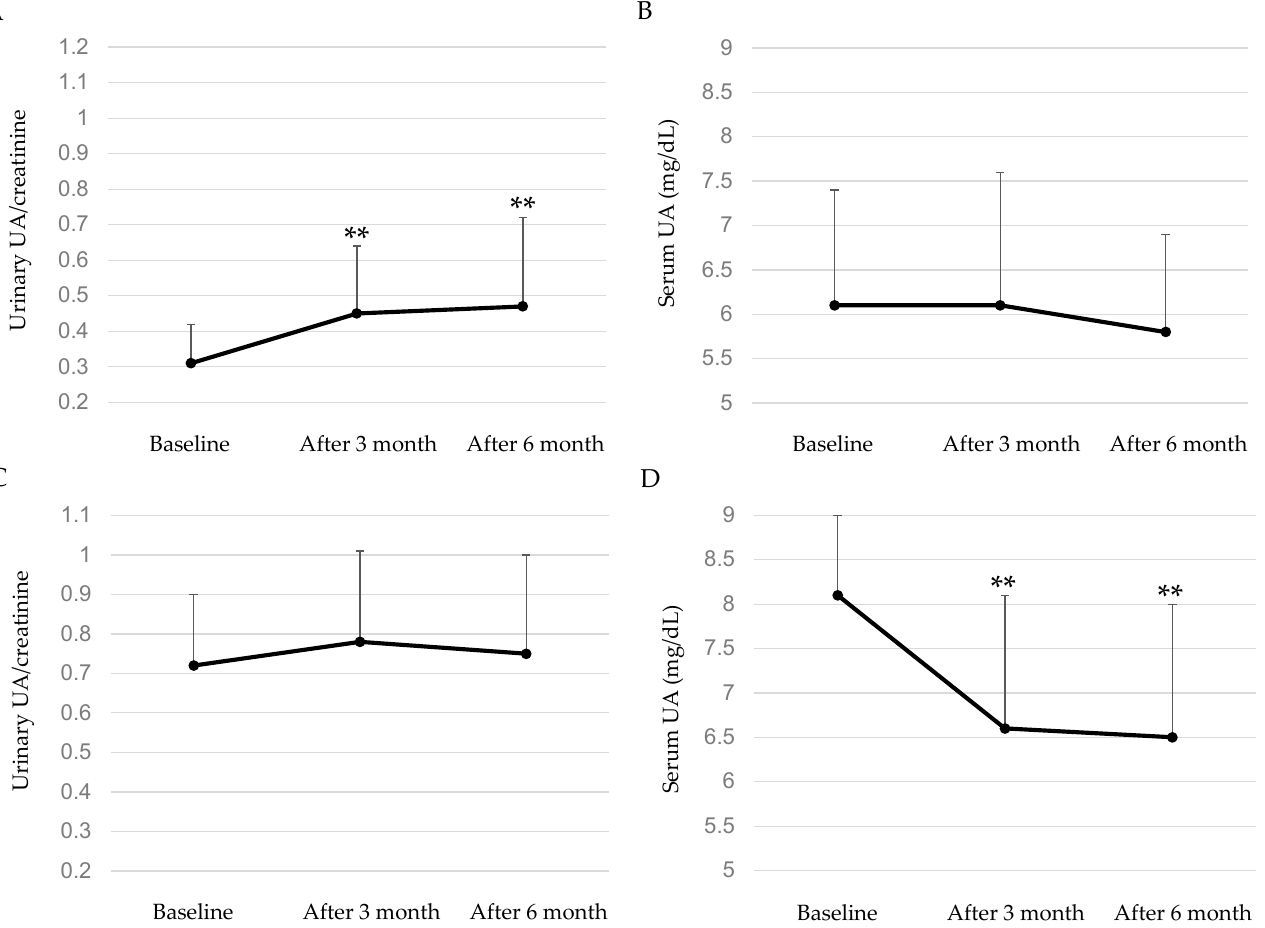
Figure 3. The effect of dotinurad on urinary UA/creatinine and serum UA levels in patients with UA underexcretion type ( A , B ), and in patients with renal UA overload type ( C , D ). ** p < 0.05. 3.7. The Association of Urinary UA/Creatinie with Serum Creatinie and eGFR 3.7.1. Correlations between Urinary UA/Creatinine and Serum Creatinine Correlations between urinary UA/creatinine and serum creatinine were shown in Figure 4. Urinary UA/creatine was significantly and negatively correlated with serum creatine levels at baseline and at 6 months after the start of dotinurad, and urinary UA/creatine tended to be negatively correlated with serum creatine levels after 3 months. The change in urinary UA/creatine after 3 months was significantly and negatively correlated with change in serum creatine.